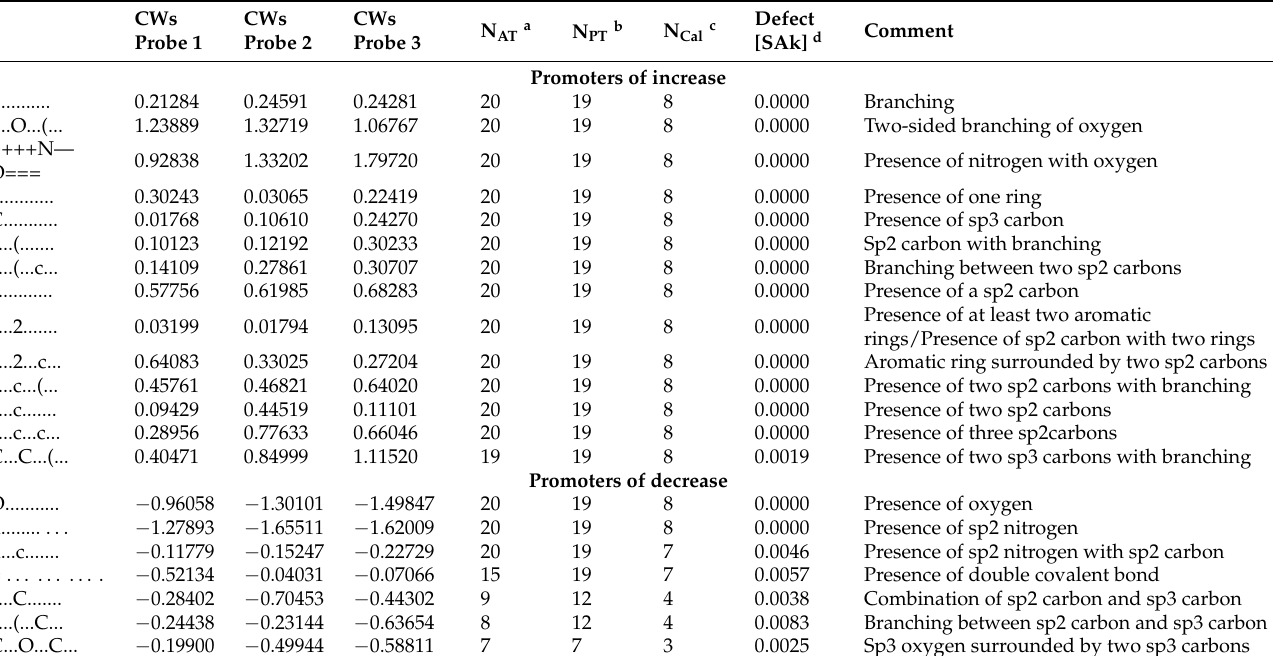
Table 3. Promoters of increase and decrease of pIC 50 endpoint value from split 2 and their description.